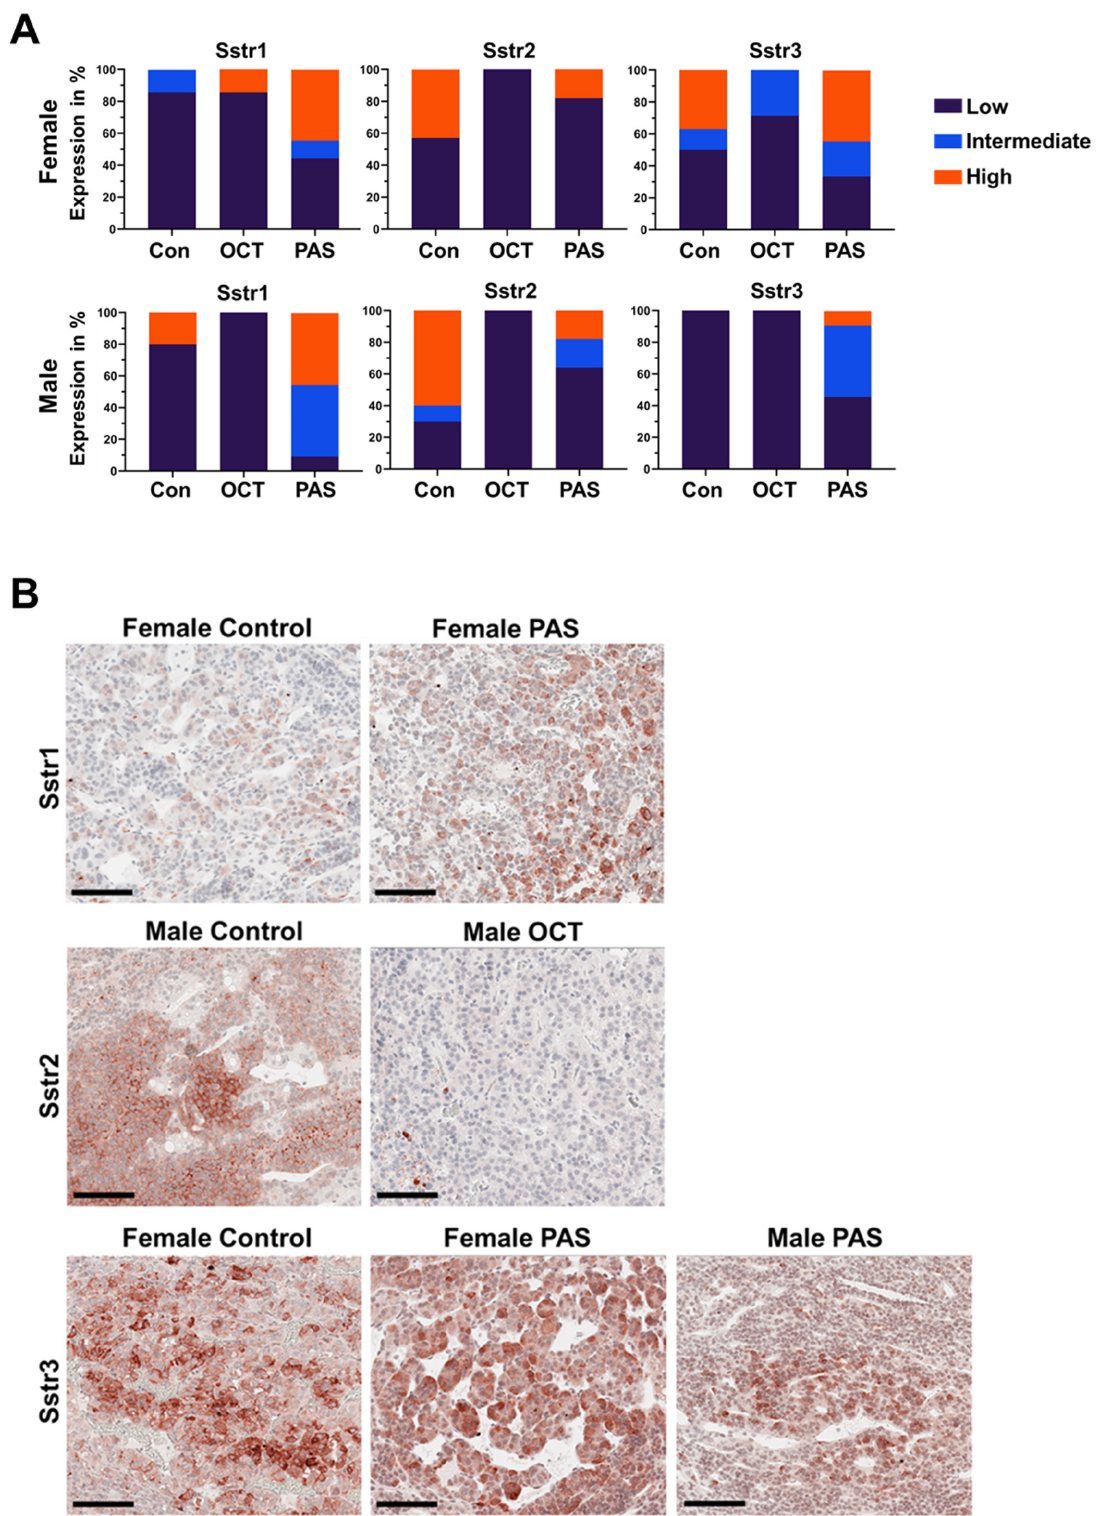
Figure 6. Expression of Sstr receptors in rat PTs following treatment. ( A ) Scoring of the expression of Sstr1,2 and 3 in rat tumors following treatment. In each treatment group/gender at least three tumors were stained. ( B ) Shown are representative samples from the treatment groups that showed changes in Sstr protein expression in their tumors upon treatment. PAS, pasireotide; OCT, octreotide. Original magnification: ×200. Size bar: 200 µm.